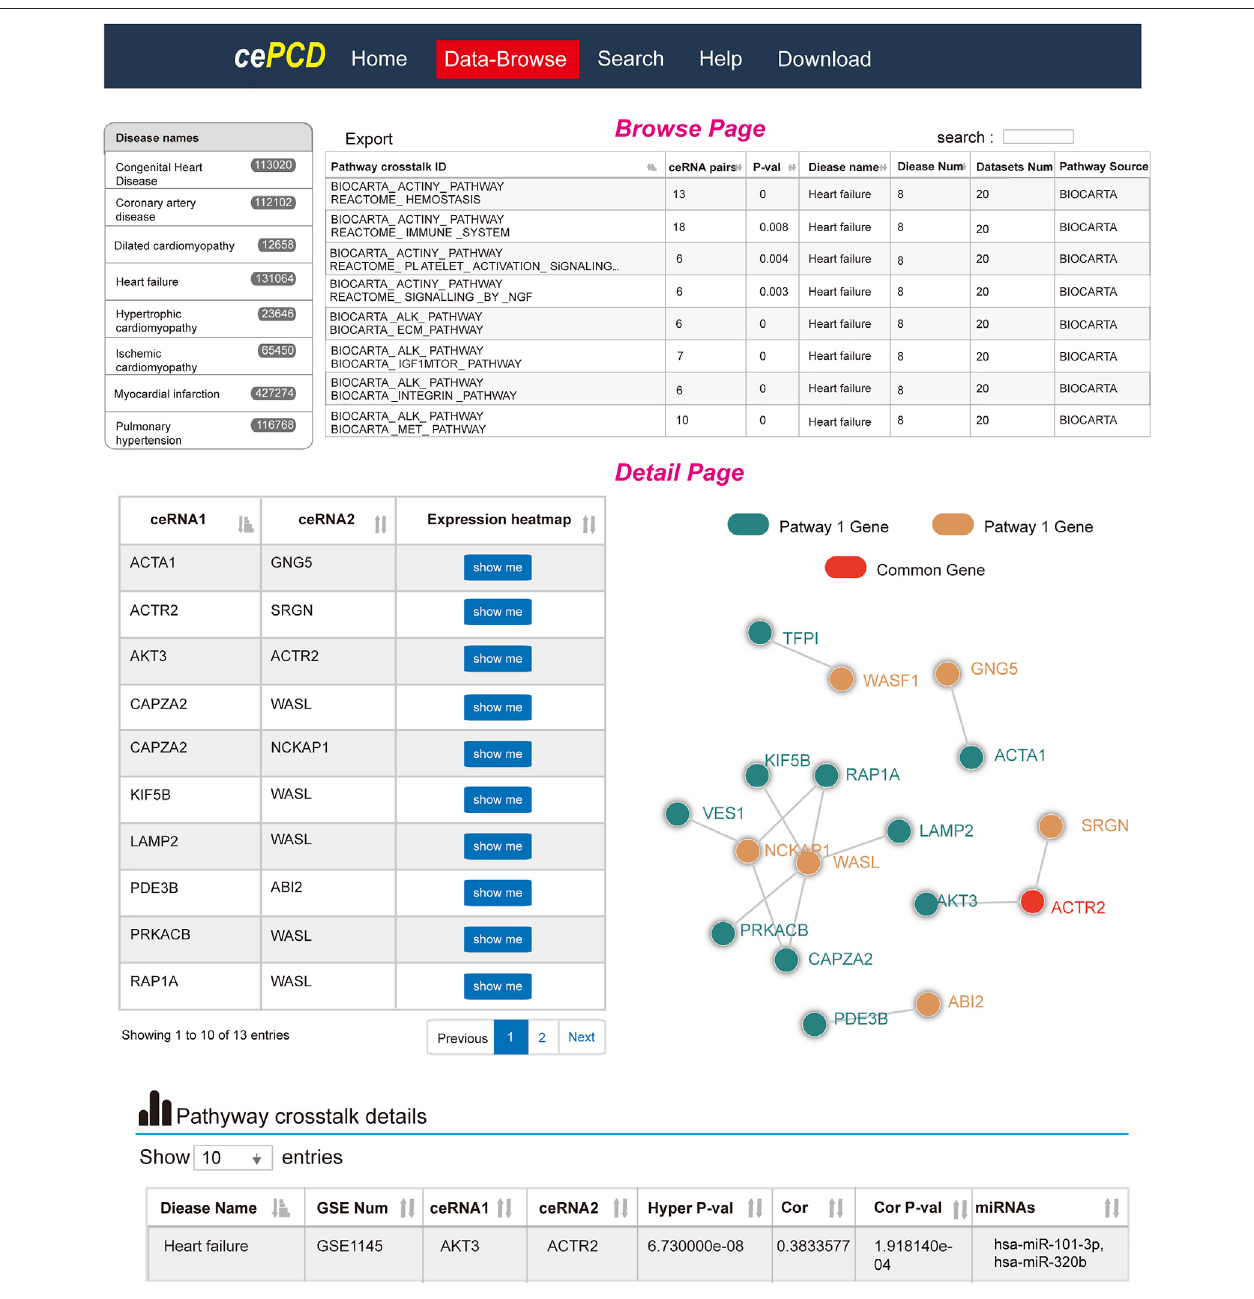
FIGURE 7 | Website design of cePCD, which provides comprehensive annotations for pathway crosstalk in CVDs.